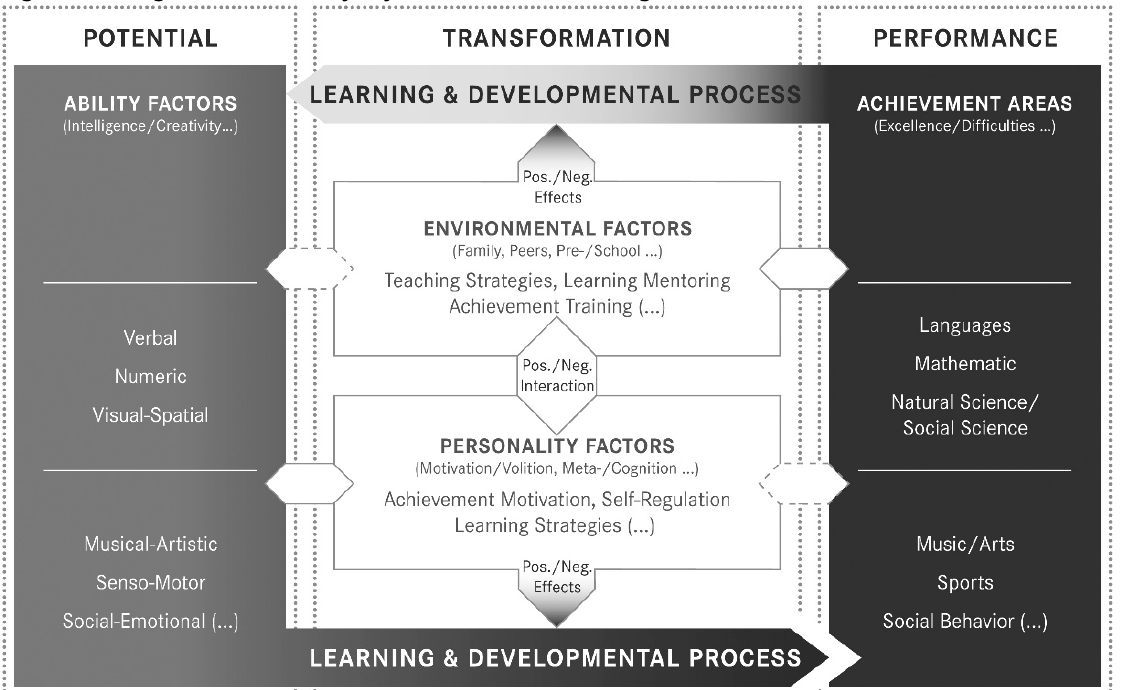
Figure 1 Integrative Model of Giftedness and